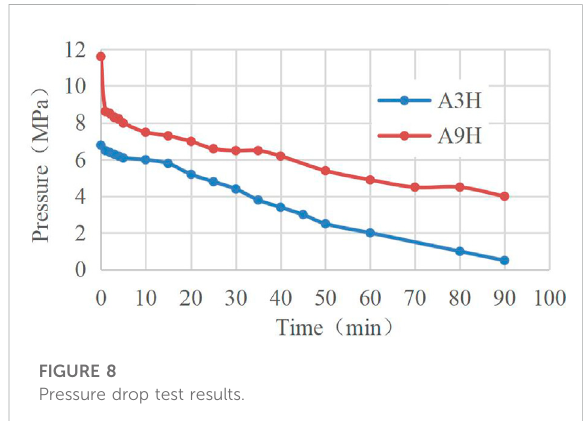
FIGURE 8 Pressure drop test results.